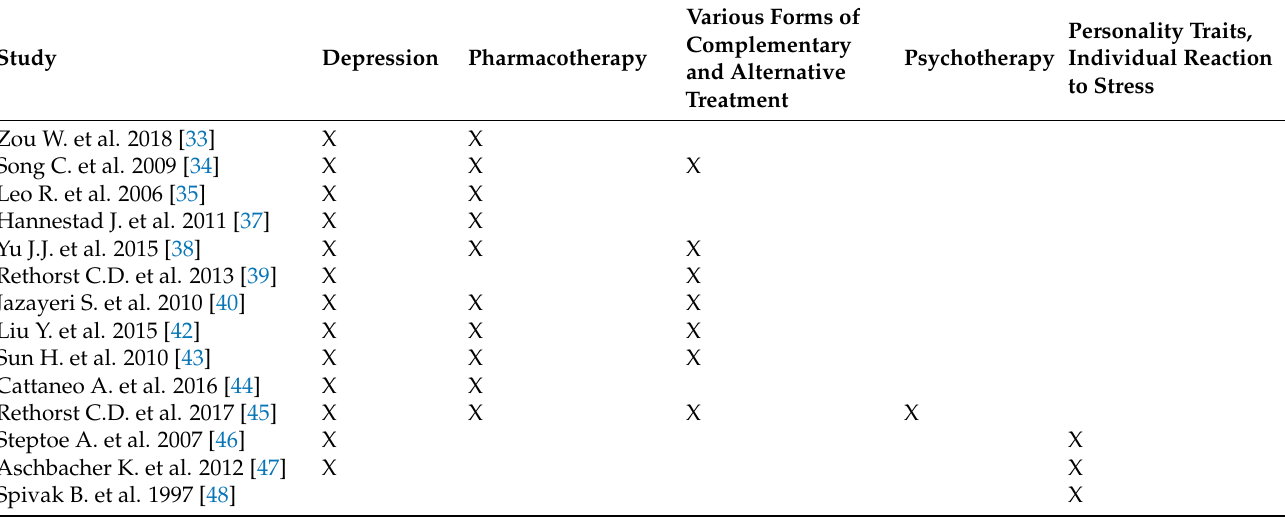
Table 2. Examples of studies on IL-1 levels with different kinds of co-factors (X marks studies focused on mentioned area).